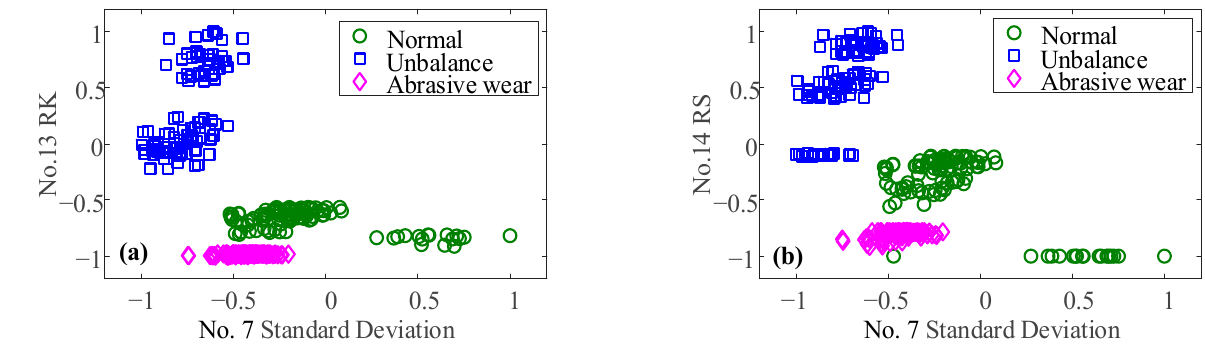
Figure 16. Scatter of ( a ) standard Deviation and RK ( b ) standard Deviation and RS.